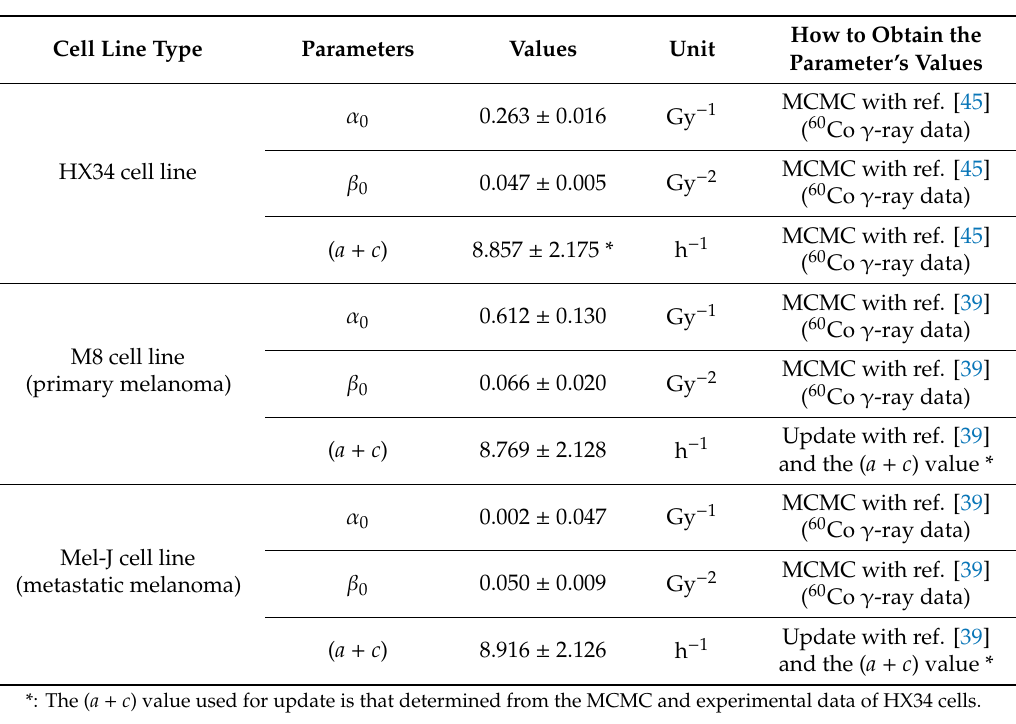
Table 1. Model parameters determined by Markov chain Monte Carlo (MCMC) simulation of human melanoma.